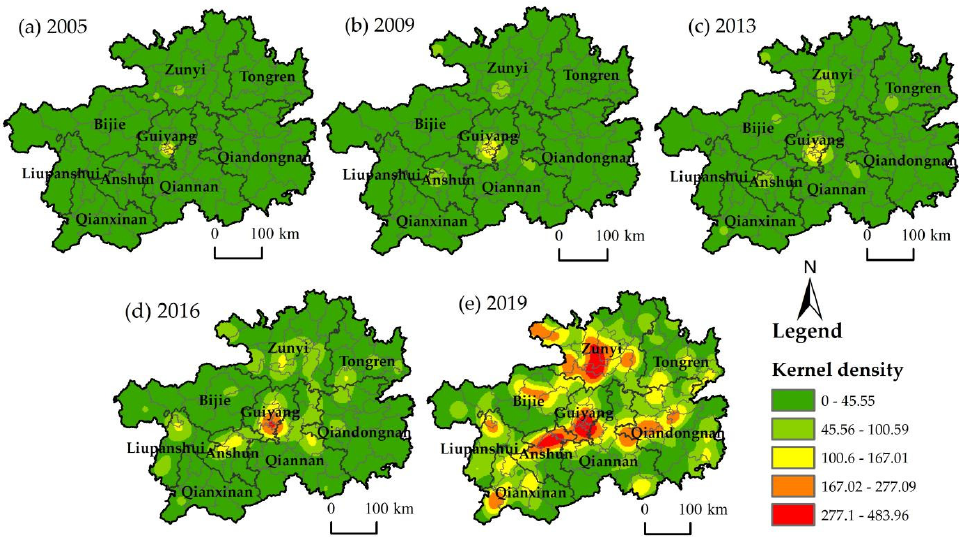
Figure 6. Kernel density map of spatial distribution of A-level scenic spots in Guizhou Province, ( a ) Kernel density of spatial distribution of A-level scenic spots in 2005, ( b ) Kernel density of spatial distribution of A-level scenic spots in 2009, ( c ) Kernel density of spatial distribution of A-level scenic spots in 2013, ( d ) Kernel density of spatial distribution of A-level scenic spots in 2016, ( e ) Kernel density of spatial distribution of A-level scenic spots in